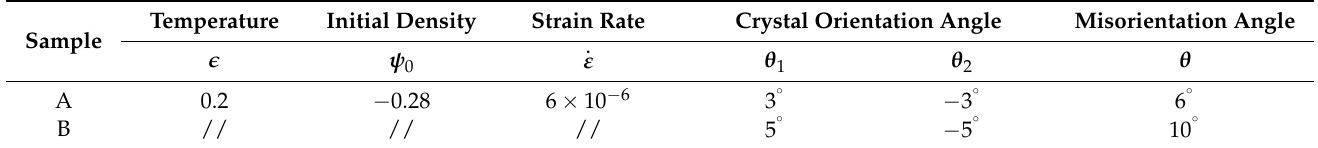
Table 1. Parameters for sample